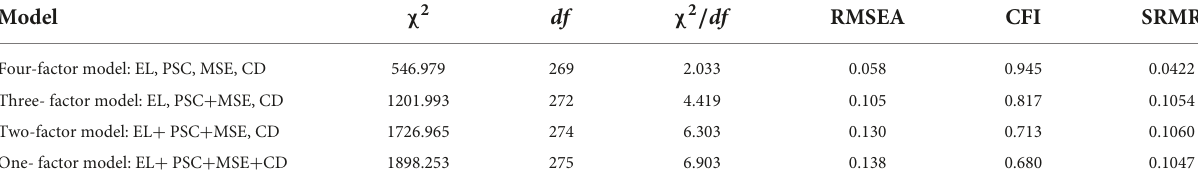
TABLE 1 Results of confirmatory factor